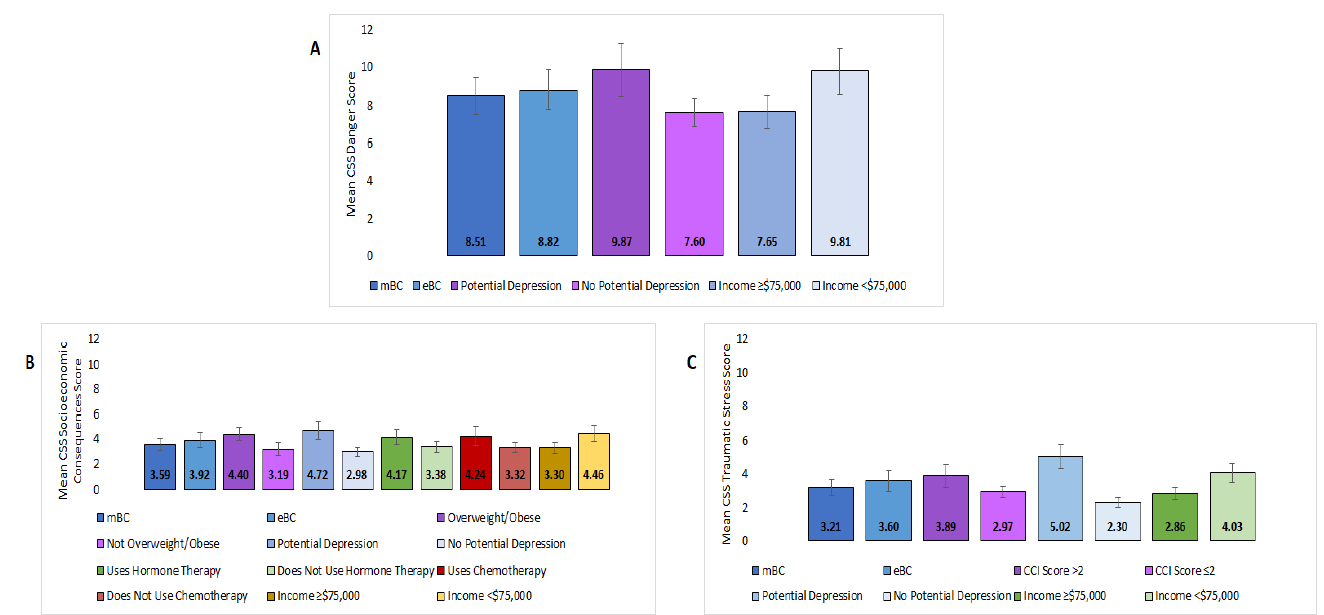
Figure 3. Adjusted means for BC type and variables significantly associated with ( A ) CSS danger score, ( B ) CSS socioeconomic consequences score, and ( C ) CSS traumatic stress score. CCI, Charlson Comorbidity Index; CSS, COVID Stress Scale; eBC, early-stage breast cancer; mBC, metastatic breast cancer. Note: Error bars show 95% confidence intervals.